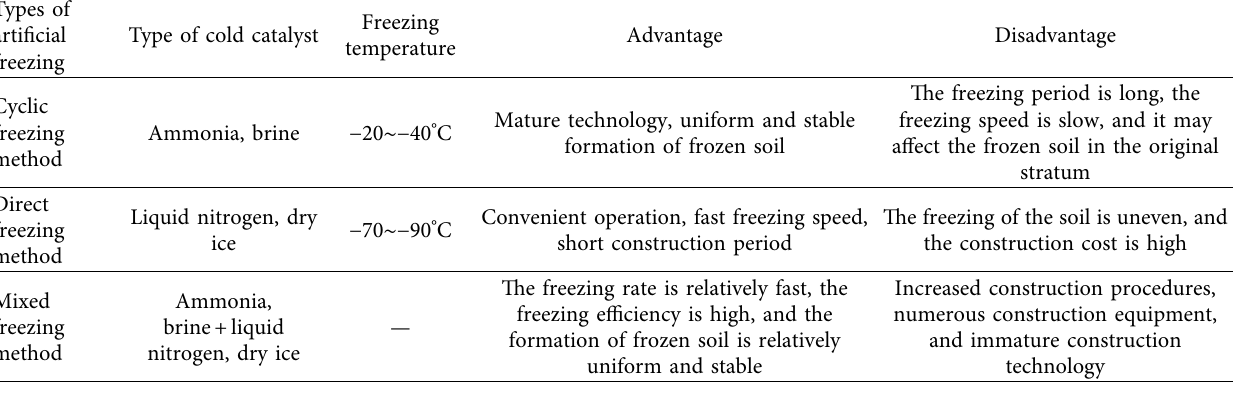
Table 1: The characteristics of the three artificial freezing